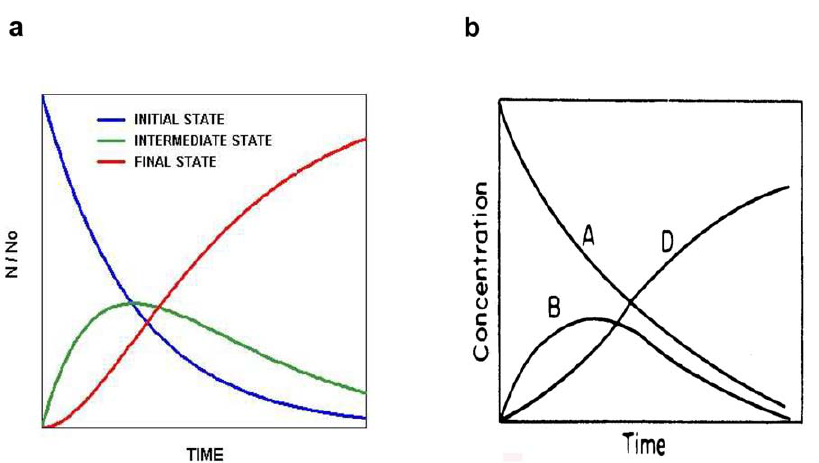
Figure 3. Three-stage cascade processes involving stochastic transitions in the hard sciences. (a) Physics: a 3-element cascade radioactive decay (adapted from Fermi Lectures: Chicago University press; 1950). This process starts at time=0 with a fixed size population of radioactive atoms all in an identical initial state, where each atom has the same probability of transitioning to an intermediate radioactive state. Atoms arriving in that intermediate state are immediately subject to a probability of transitioning to the final stable state. The intermediate state reaches a maximum, when the number of atoms/unit time entering it, is the same as the number leaving it. Using the 2 probability parameters one can calculate the time courses of the relative number of atoms in each state. An important factor which simplifies the mathematics is that individual transitions are of very short duration relative to the duration of the population transition. (b) Chemistry: a 3-stage consecutive reaction of solutes within a solvent (adapted from Chemical Engineers Handbook (1973) with kind permission of the publisher). Gives the concentration-time profile for consecutive reaction A R B R D.